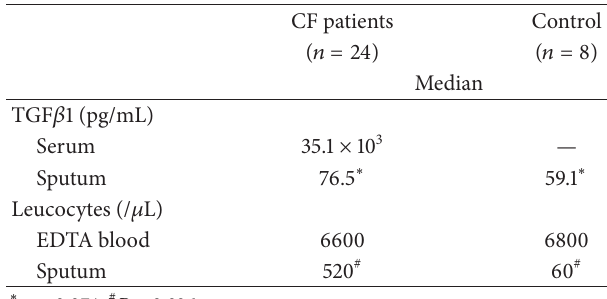
Table 2: TGF 𝛽 1 and leucocytes in blood and sputum.